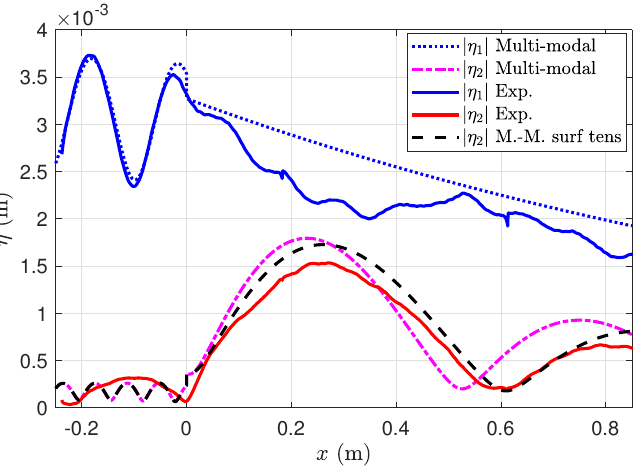
Figure 16. Comparison of the experimentally measured amplitude of the first (blue solid line) and second (red solid line) harmonics ( multimodal model. At the second order, the theoretical beating is computed with (black dashed line) and without (magenta dash-dotted line) surface tension. Wave frequency ω = 4 π s − 1